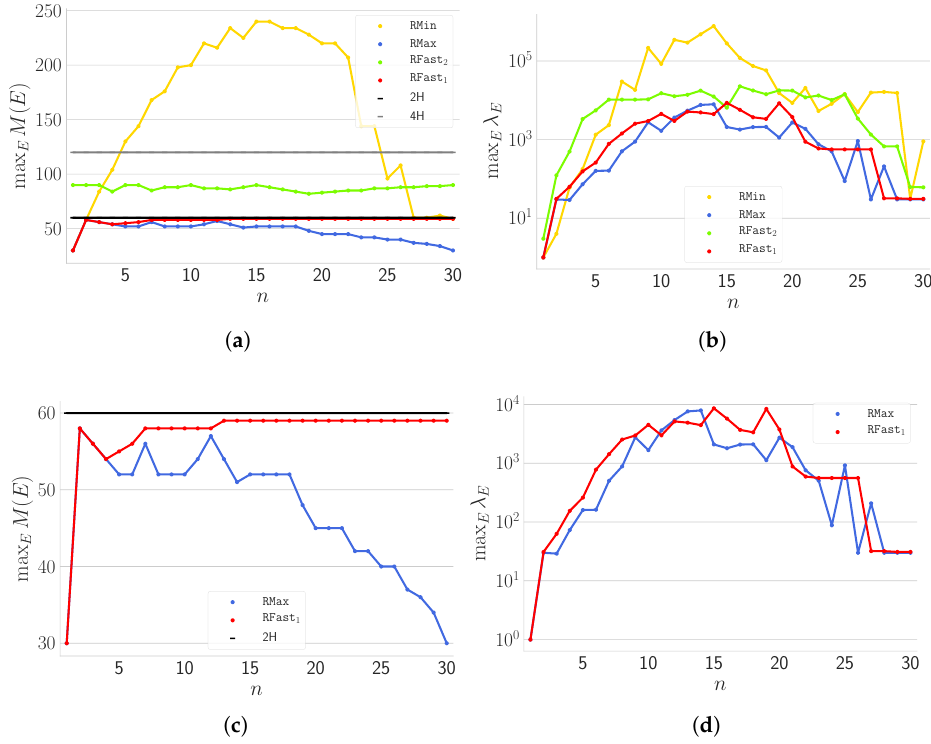
Figure 3. Experiments conducted on all possible ordered instances obtained by setting H = 30 and hence considering n varying in { 1,2, . . . ,30 } . Panels ( a , c ) refer to maximum M ( E ) , whereas panels ( b , d ) refer to maximum λ E . Panels ( c , d ) show strategies that, experimentally, exhibit